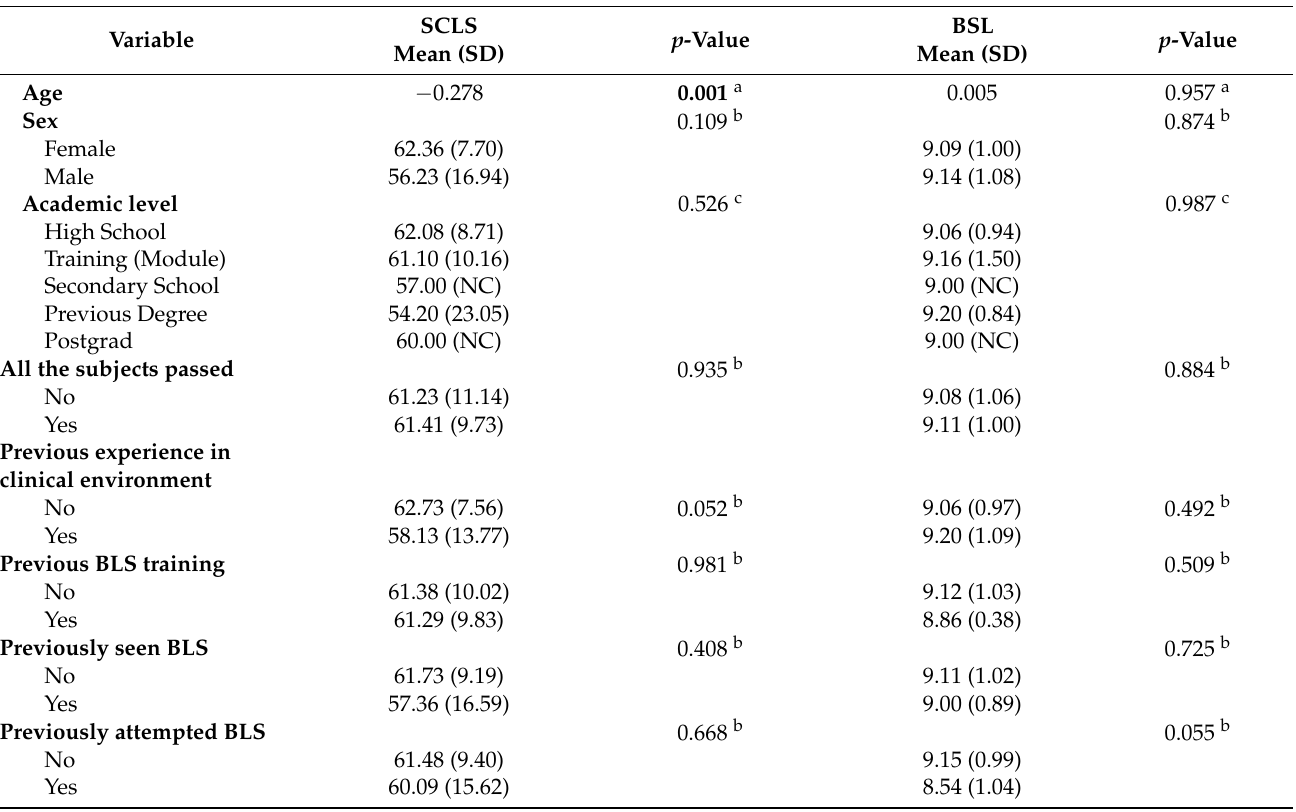
Figure 2. Knowledge regarding BLS in pregnant women: questionnaire score boxplot. The asterisks mean abnormally far values (distance on the median greater than 3 interquartile ranges). Table 3. Relationship between sociodemographic and academic variables with SCLS and BLS Knowledge.